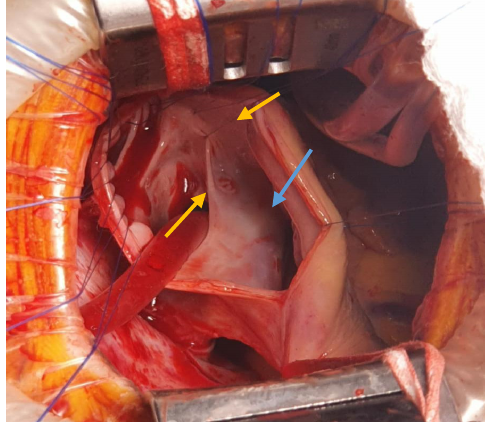
Figure 4. Intra-atrial look of the SV-ASD with PAPVD (pulmonary veins ostia—yellow arrows; ASD—blue arrow).